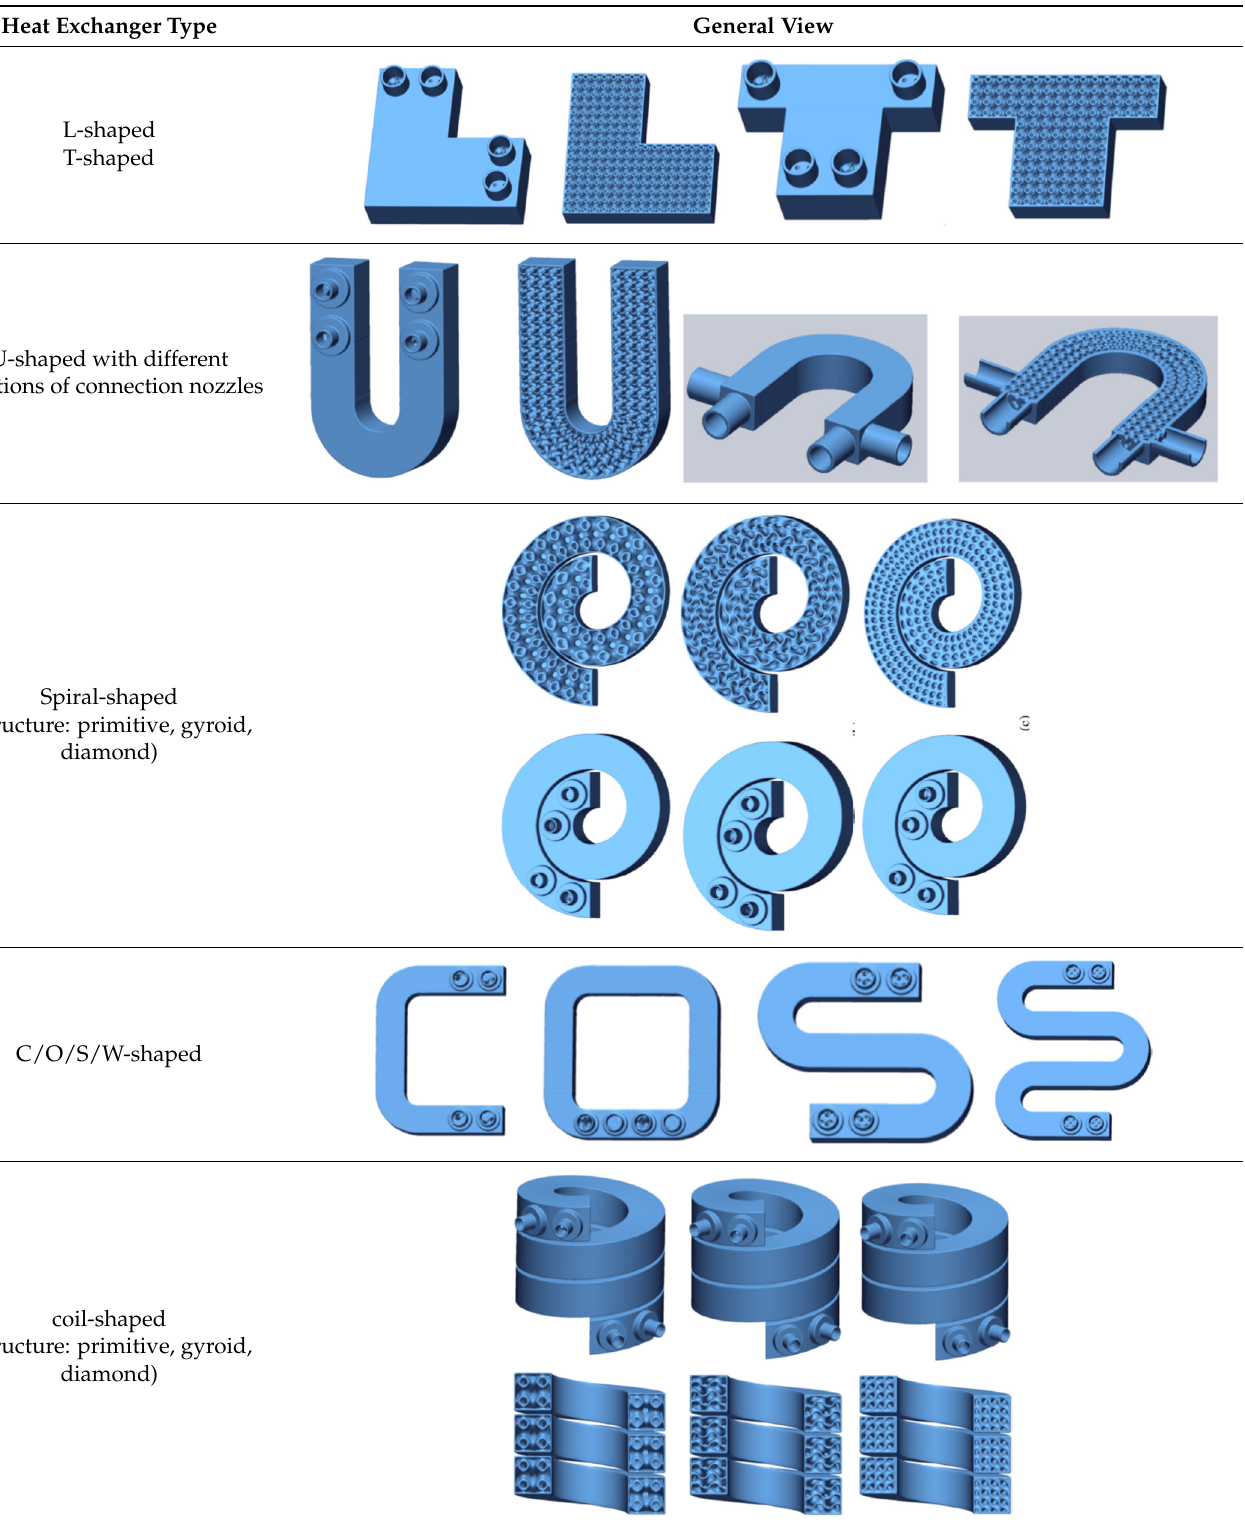
Table 2. View of design proposals for heat exchangers according to [47].